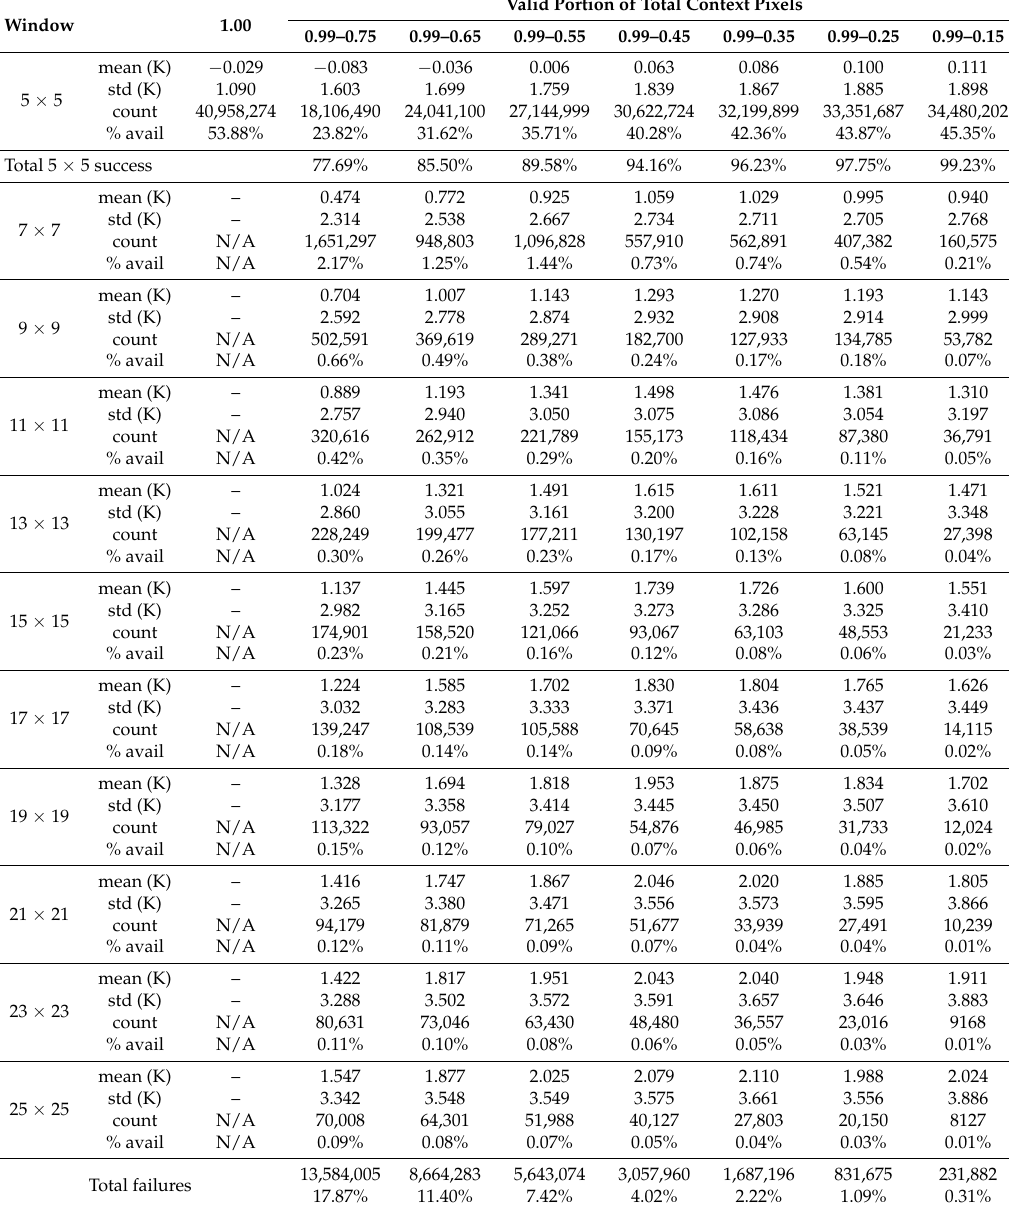
window values shown, with statistics reported for pixels that achieve the valid context percentage at each window size. After the process is exhausted at the 25 × 25 window, the remaining pixels without a solution for each percentage are tallied in the total failures row at the bottom of the table. Table 5. Mean and standard deviation of brightness temperature differences between the central pixels and the contextual surrounds at each window level per percentage level. Numbers shown in the 5 × 5 window row report statistics for pixels that would be added to the 1.00 pixels if the valid context percentage shown was used to accept contextual estimates. The percentage of total pixels with estimates available at the 5 × 5 window for each valid context percentage is also shown. The rows for each subsequent window size describe the number of temperature estimations that would be added from failures at the previous window size by expanding the examined window, and the subsequent means and variances of pixels included from these window sizes. A total of 76,023,810 pixels were examined over the 36 images used in the